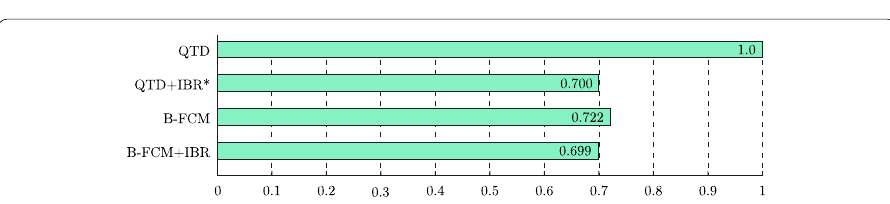
Fig. 28 Normalized computational time needed for the numerical integration of the cut cells (violin-shaped domain)